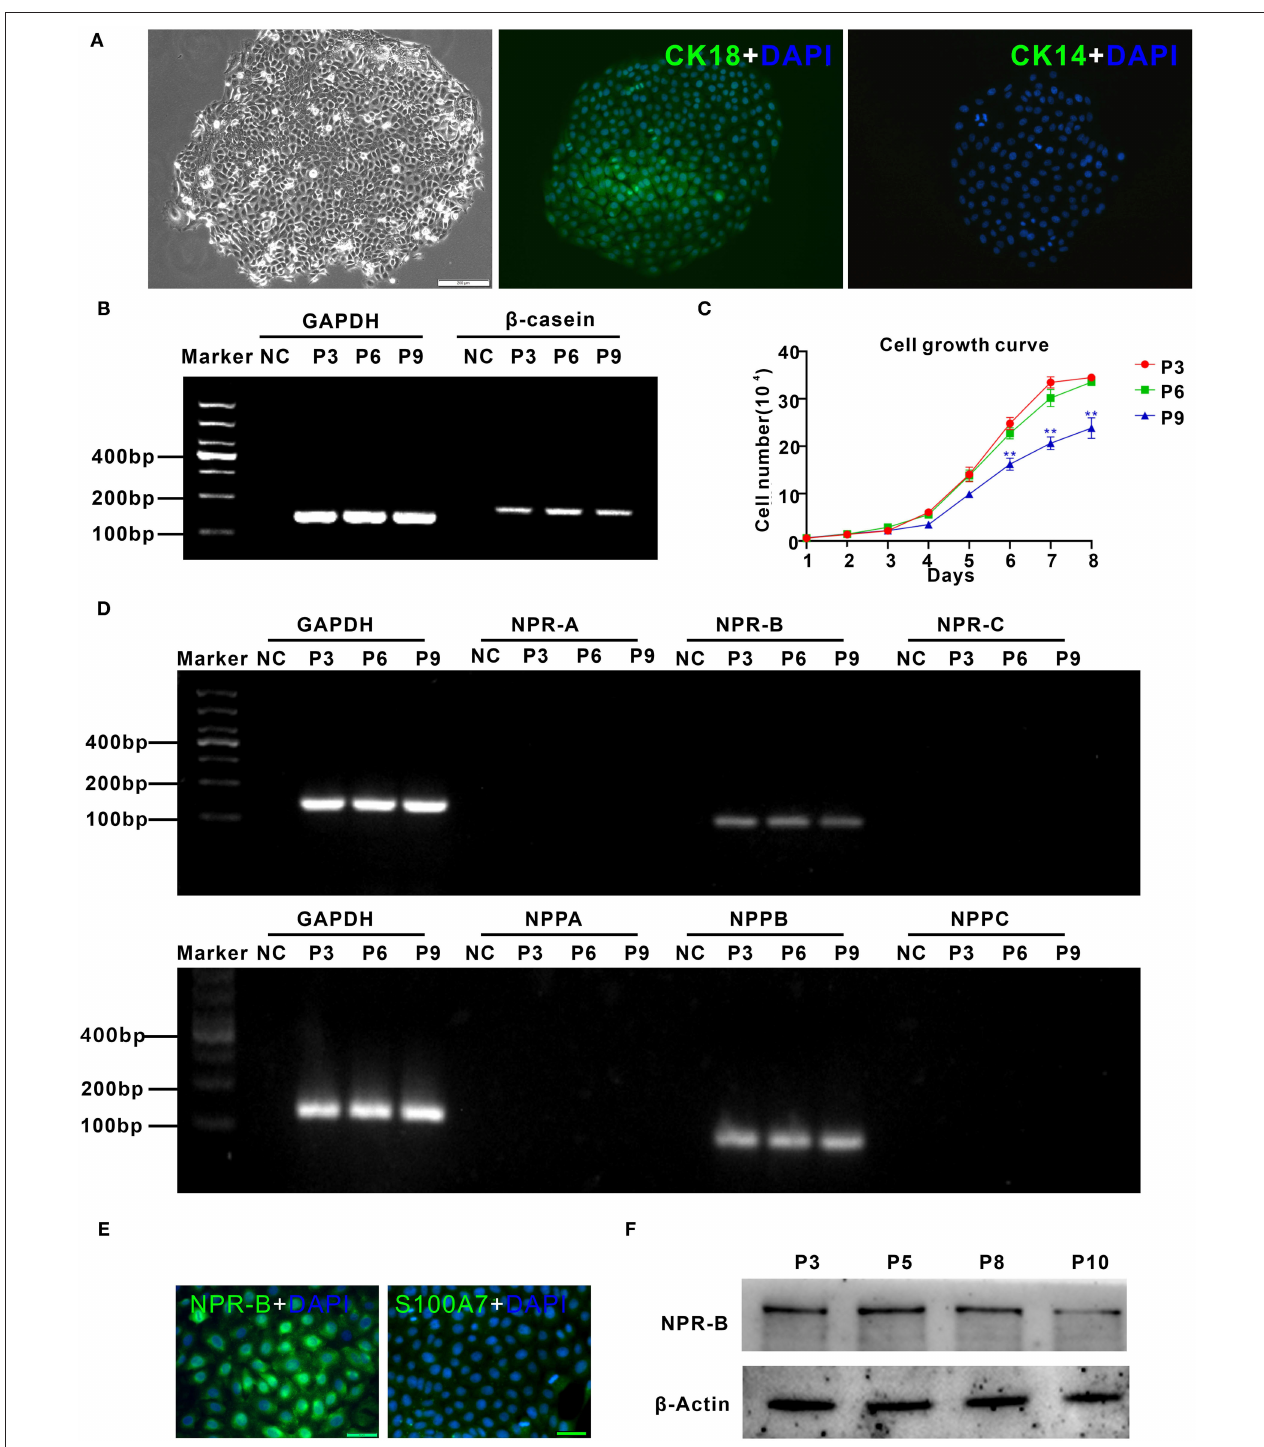
FIGURE 2 | Characterization of goat mammary epithelial cells (MECs) and the expression of natriuretic peptides and natriuretic peptide receptors in goat MECs. (A) Characterization of goat MECs. Left, morphology of the isolated goat MECs (P5); middle, immunofluorescence result of cytokeratin 18 (CK18) in goat MECs; right, immunofluorescence result of cytokeratin 14 (CK14) in goat MECs. (B) Goat MECs at passages 3, 6, and 9 expressed β -casein detected by reverse transcription-PCR (RT-PCR). (C) Cell growth curve of goat MECs at passages 3, 6, and 9. (D) Goat MECs at passaged 3, 6, and 9 expressed NPPB messenger RNA (mRNA) and NPR-B mRNA, but not NPPA, NPPC, NPR-A, and NPR-C mRNA detected by RT-PCR. (E) Immunofluorescence result of NPR-B and S100A7 in goat MECs. (F) Goat MECs at passages 3, 6, and 9 expressed NPR-B detected by Western blotting. Full-length blots are given in Supplementary Figures S4, S5 .